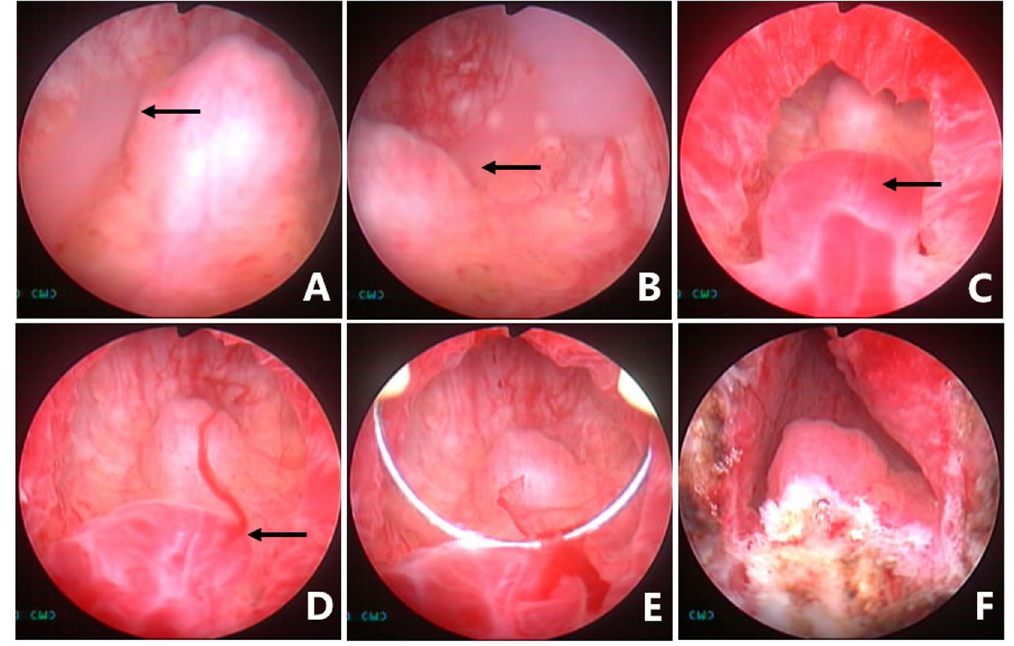
Figure 11. Management of a cavernous hemangioma at the posterior urethra. ( A ) Normal white jelly-like seminal fluid poured from the right ED orifice upon seminal vesicle massage. ( B ) Normal white jelly-like seminal fluid poured from the left ED orifice upon seminal vesicle massage. ( C ) An obvious cavernous hemangioma with a size of about 5 × 5 mm was seen at about 5 mm away from the distal margin of the verumontanum. ( D ) Active bleeding was observed on the cavernous hemangioma. ( E ) The cavernous hemangioma was resected and/or fulgurated with an electric cutting loop. ( F ) The verumontanum area after the hemangioma was resected and/or